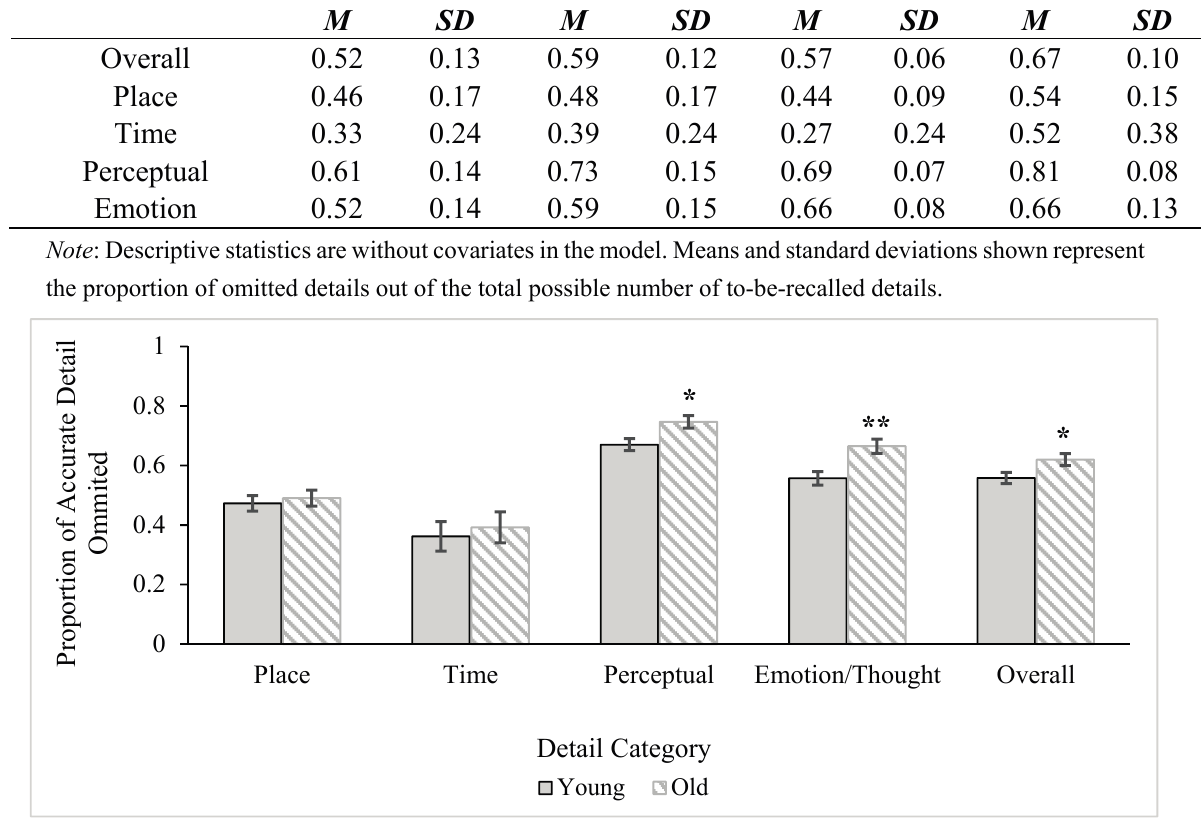
Figure 4. Age differences in errors of omission for details overall and by category. Bars represent ± 1SE. Single asterisks mark significant effects at the p < 0.05 level and double asterisk marks significant effect at the p < 0.01 level. Age differences in overall detail disappeared after including covariates (episodic memory, education) in the model, but multivariate effects ( perceptual and emotion/thought ) remained